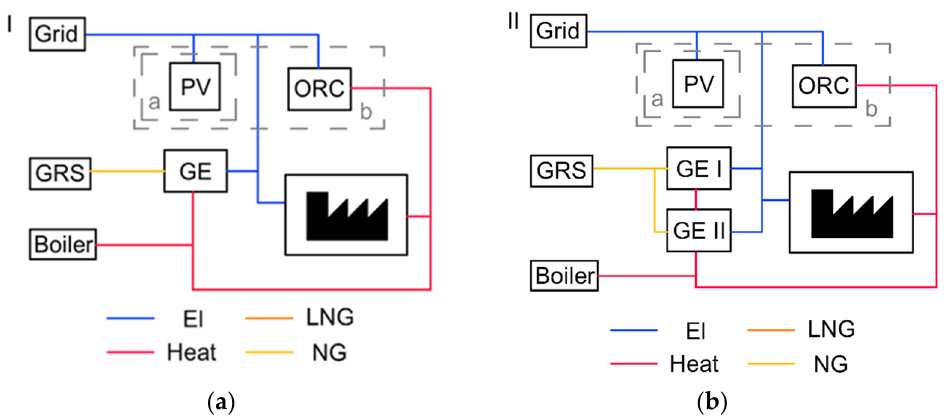
Figure 2. Scheme presentation of systems I ( a ) and II ( b ) with modification used in the model.